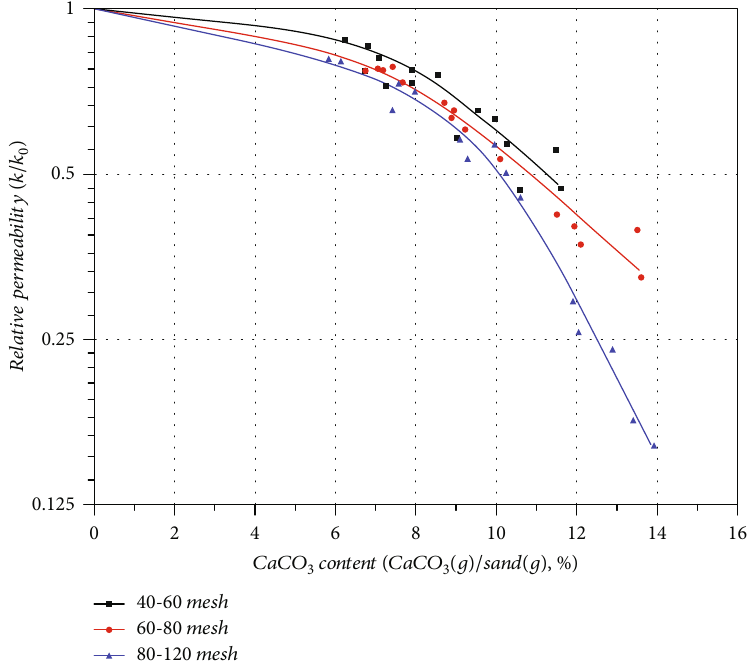
Figure 4: Correlation between calcium carbonate content and change in normalized (relative)